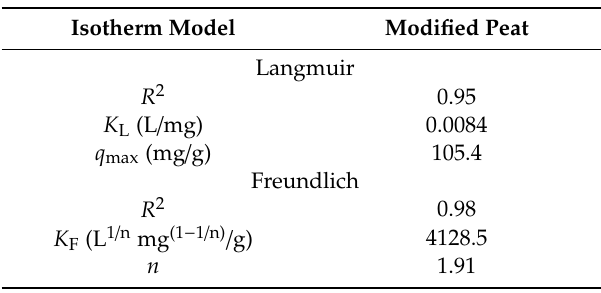
Table 3. Isotherm